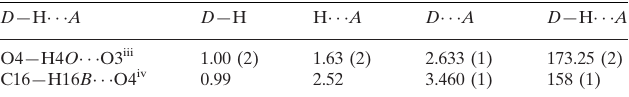
Hydrogen-bond geometry (A˚ , (cid:3)